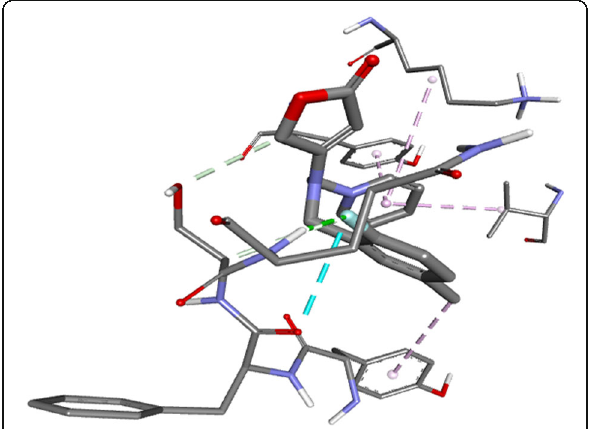
Fig. 7 The interaction between the compound with the highest docking score and